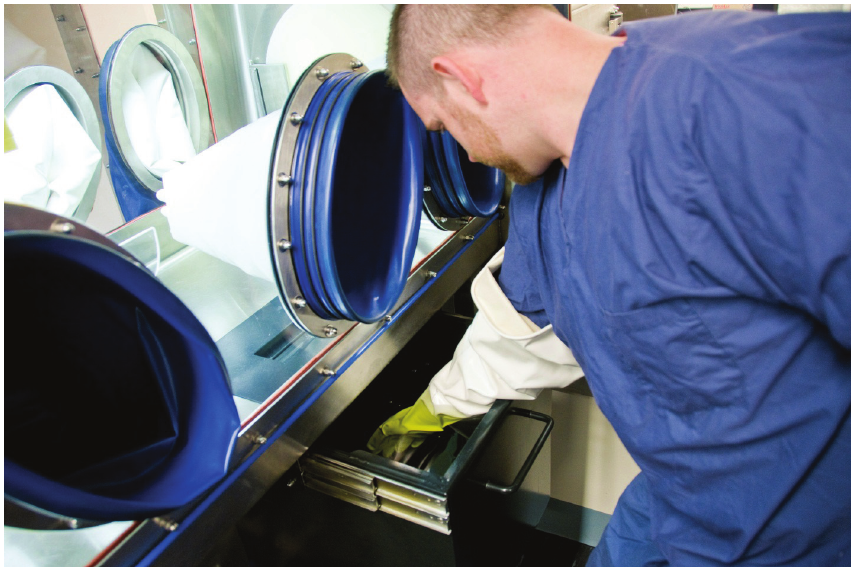
Figure 7. Dunk tank filled with disinfectant attached to the Class III BSC. A liquid barrier created by the appropriate disinfectant protects the researcher by ensuring that contaminants within the BSC are fully contained. Supplies are passed through the dunk tank and into the BSC. A black lid covers the base of the BSC and prevents liquid from splashing into the experimental